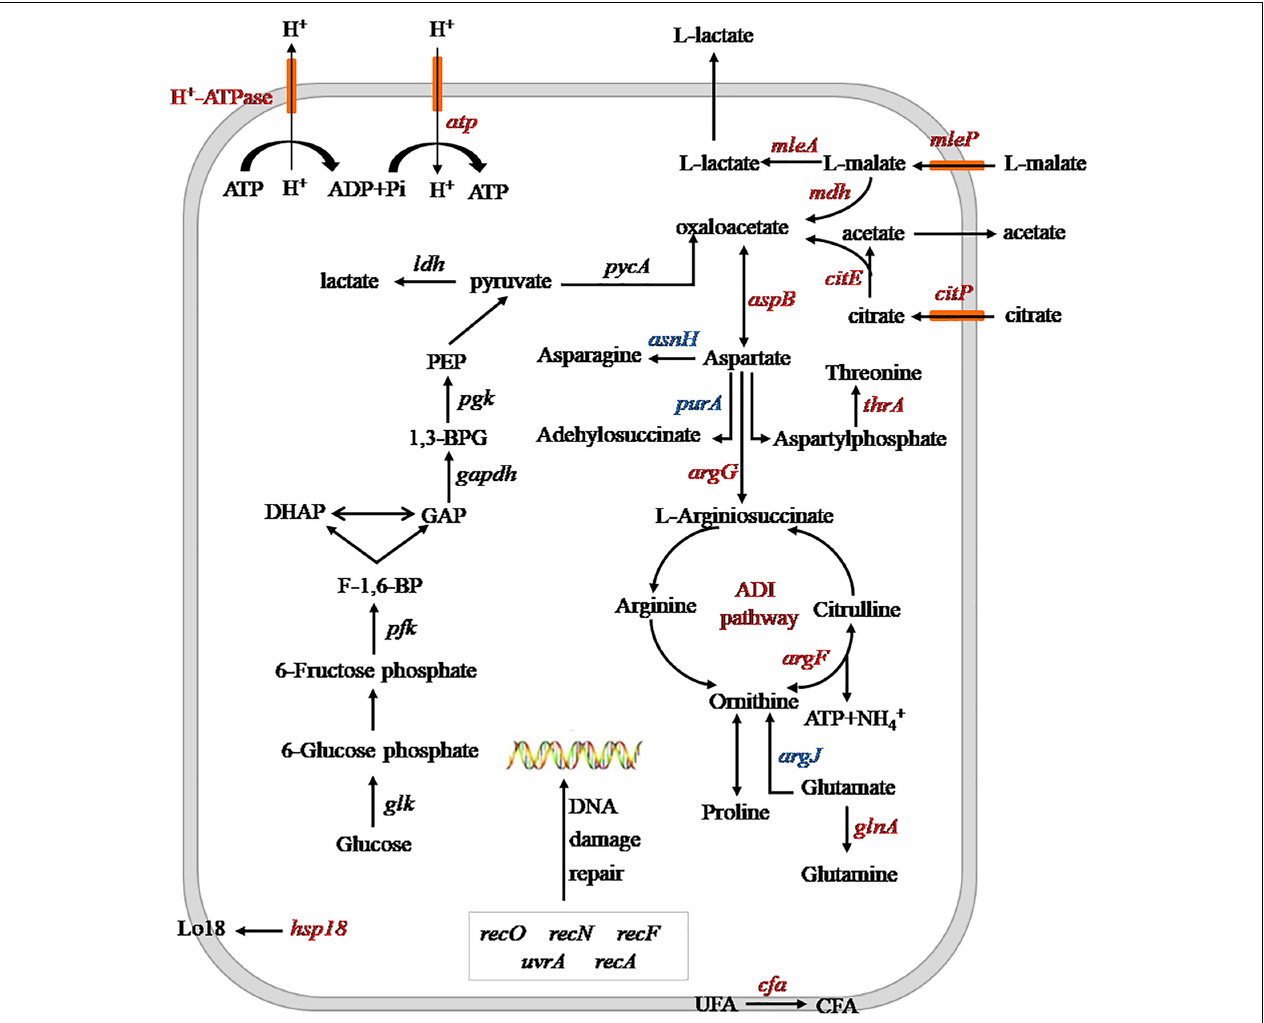
FIGURE 6 | Schematic diagram of heterologous expression of the argG gene in SL09 at pH 3.7. Genes are in italics, the red color represents increased expression of genes or enzyme activity, the blue color represents decreased expression of genes. PEP, phosphoenolpyruvate; 1,3-BPG, 1,3- diphosphoglycerate; GAP, glyceraldehyde phosphate; DHAP, dihydroxyacetone phosphate; F-1,6-BP, fructose diphosphate; UFA unsaturated fatty acids; and CFA, cyclopropane fatty acids; ADI, arginine